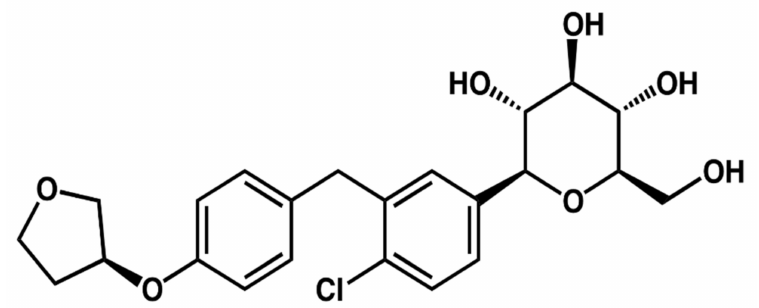
Figure 1. Chemical structure of